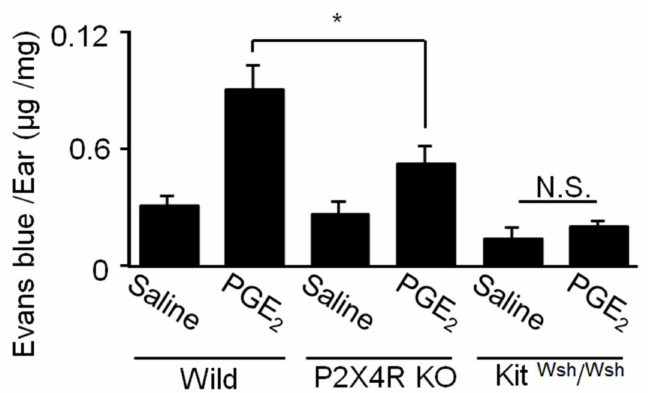
Figure 7. Comparison of prostaglandin (PG) E 2 -induced hyperpermeability in wild type, P2X4 receptor-deficient (P2X4RKO), and mast cell-deficient Kit Wsh / Wsh mice. PGE 2 (1.5 nmol) was intradermally injected into the ear and vascular permeability measured 30 min later. Data are shown as the mean ± SEM ( n = 5–6). N.S. no significant di ff erence, * p < 0.05 indicates a significant di ff